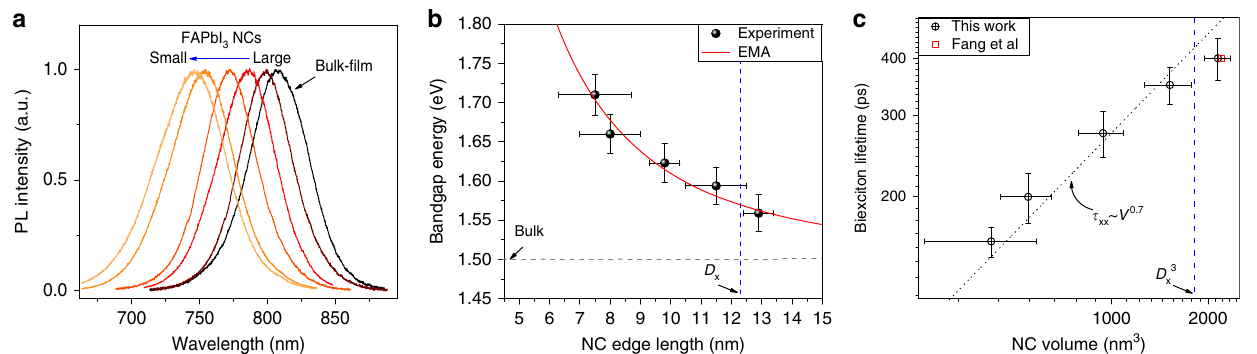
Fig. 1 Size-dependent bandgaps and biexciton lifetimes of FAPbI 3 NCs. a Normalized PL spectra of FAPbI 3 NCs in toluene with different sizes (emission peak positions are listed in Supplementary Table 1) and the FAPbI 3 polycrystalline bulk- fi lm counterpart. b Bandgap energies (black dots) as a function of the edge length of FAPbI 3 NCs together with fi tting using Supplementary Eq. (1) (red solid line). The vertical blue dashed line indicates the position of exciton Bohr diameter ( D x ). Error bars correspond to the NC size distribution and uncertainty in the measurements of TA spectra. c Biexciton Auger- lifetime (black circles) as a function of NC volume. The horizontal and vertical error bars correspond to the NC size distribution and the uncertainty in the fi tting procedure, respectively. The red square is obtained from ref. 29 (Fang